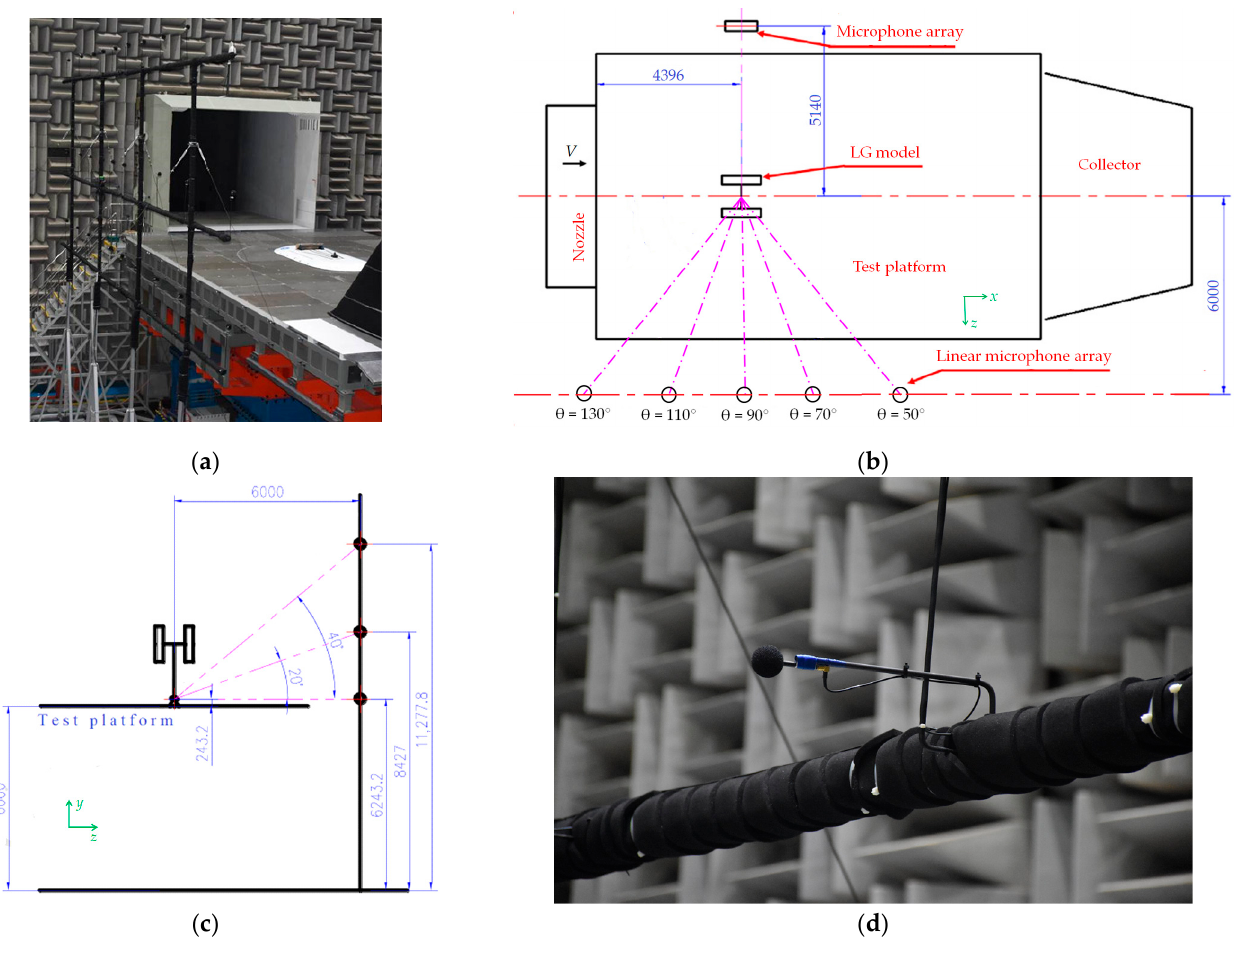
Figure 4. Landing gear noise tests in FL-17 CARDC: ( a ) photo of the linear microphone array in the anechoic test hall; ( b) scheme of the experiment (top view); ( c ) scheme of the experiment (front view); ( d ) photo of a microphone on the holder.